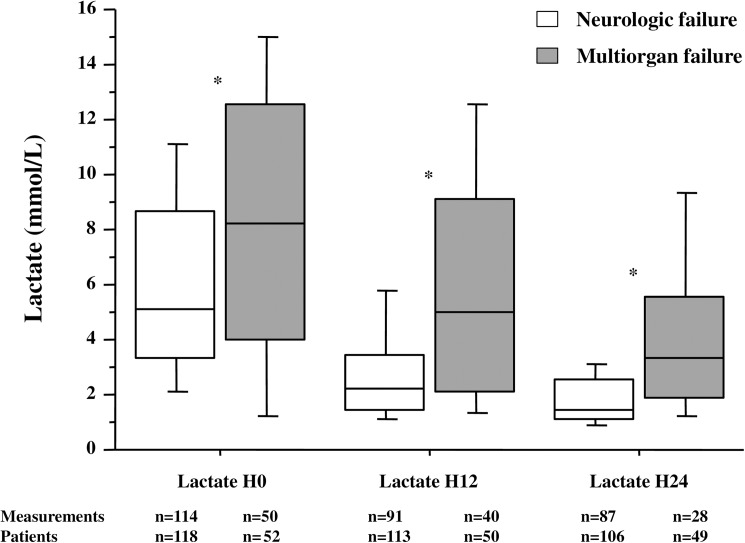
Arterial lactate levels during the 24-hours study period in MOF and neurologic failure groups.Data expressed as median and interquartile range. Comparisons between groups by Mann-Whitney test: * p<0.01